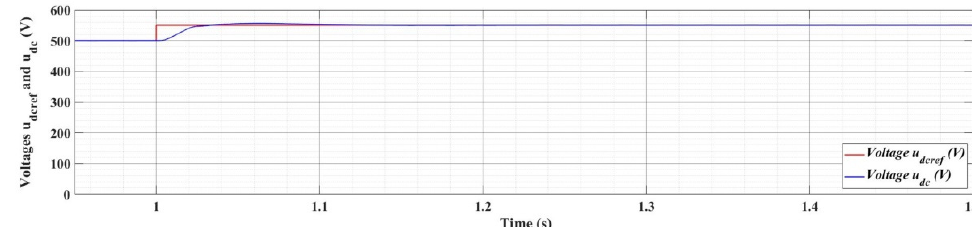
Figure 36. The time evolution of the u dc voltage for a step variation of the u dcref reference voltage from 500 V to 550 V using PI controllers and the RL-TD3 agent for the correction of the i dref , u dref and u qref commands (signal evolution of the type 1 PV array).